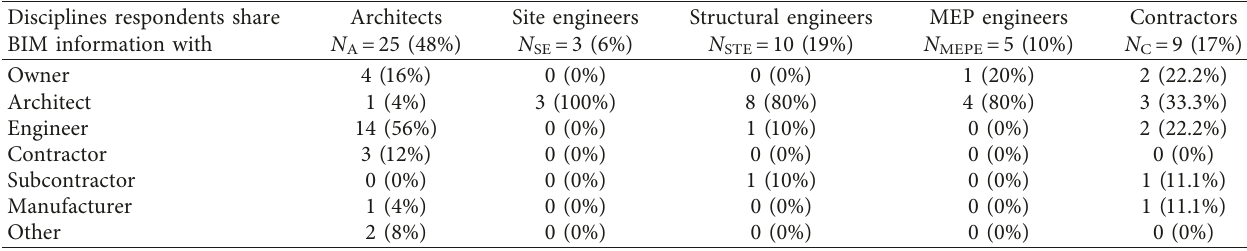
Table 7: Relationship between the role of the respondent and the disciplines they primarily share BIM information with when working on educational facility projects.